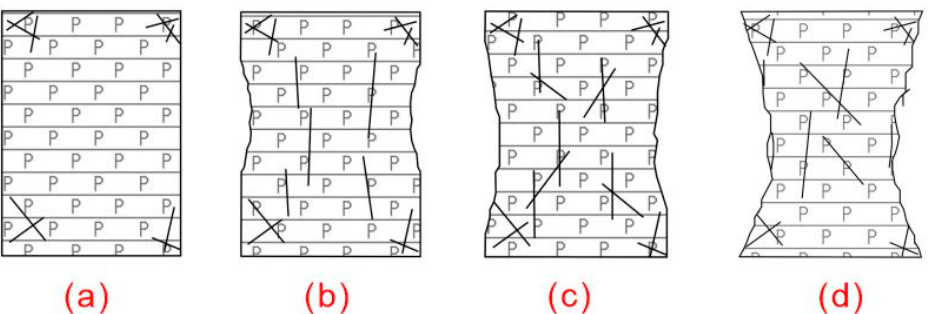
Figure 9. Pillar cracking and failure evolution process: ( a ) Pillar corner stress concentration, resulting in peeling; ( b ) Pillar surface peeling, internal pressure crack; ( c ) Pillar surface continued to peel off, producing oblique shear stripes; ( d ) Pillars failed, leaving little residual